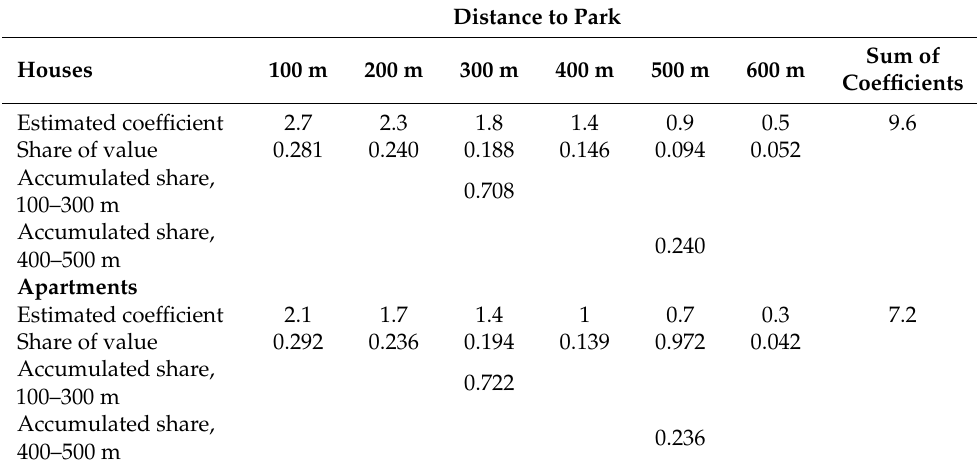
Table A1. Results and information from Panduro and Veie